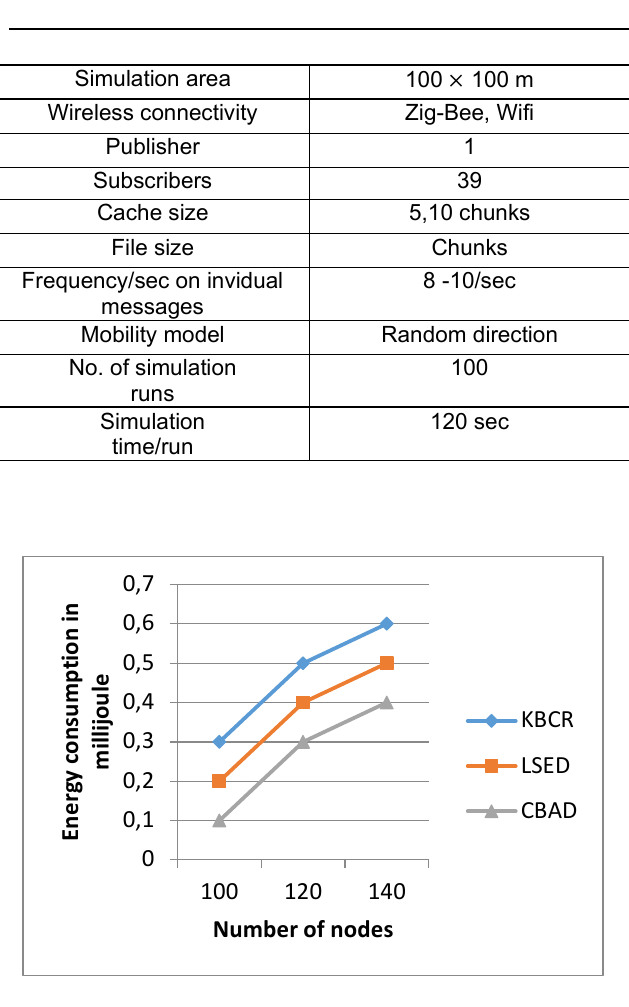
Figure 4. Comparison between Energy consumption (mj) and number of nodes